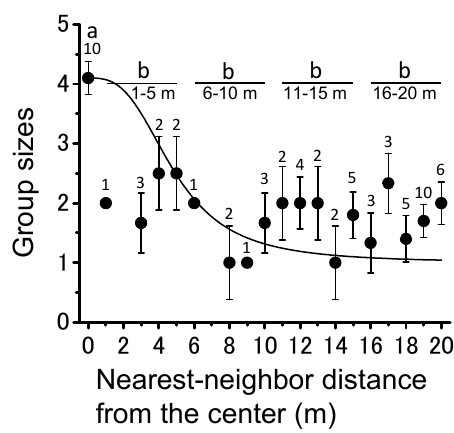
Figure 5. The relationship between trees roosted on by the largest group of gregarious Schistocerca gregaria nymphs and other group sizes associated with distance from the center (m). Different letters above circles indicate significant differences in group size based on the sum of every 5 m at p < 0.05 (Steel–Dwass test). Numbers above circles are sample sizes. Error bars mean SE. See group sizes in Figure 2.